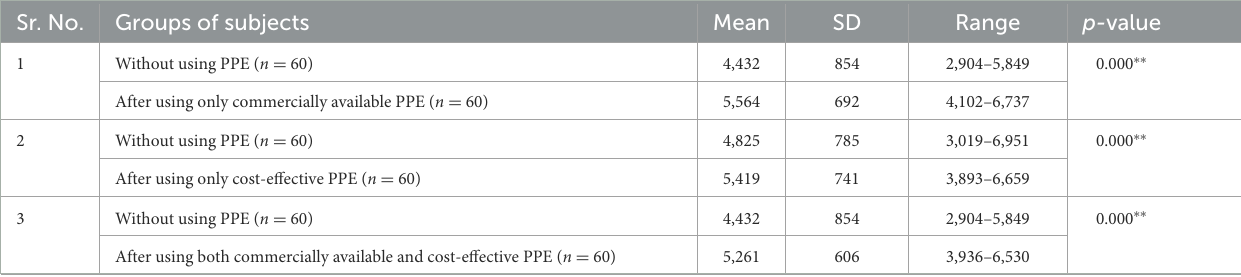
TABLE 4 Acetylcholinesterase activity (U/L) among different groups of subjects. Sr.